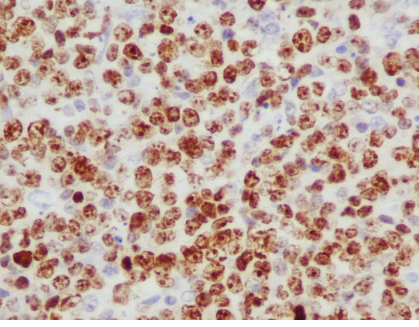
Figure 5: Positive Ki67 (immunohistochemistry, original magnifi- cation ×